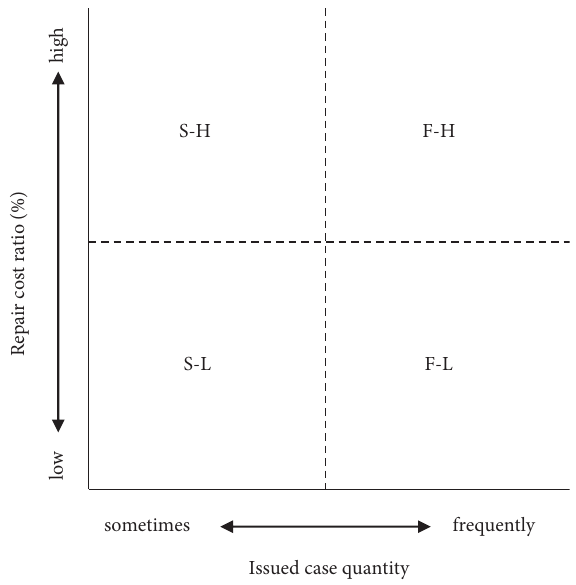
Figure 2: Research